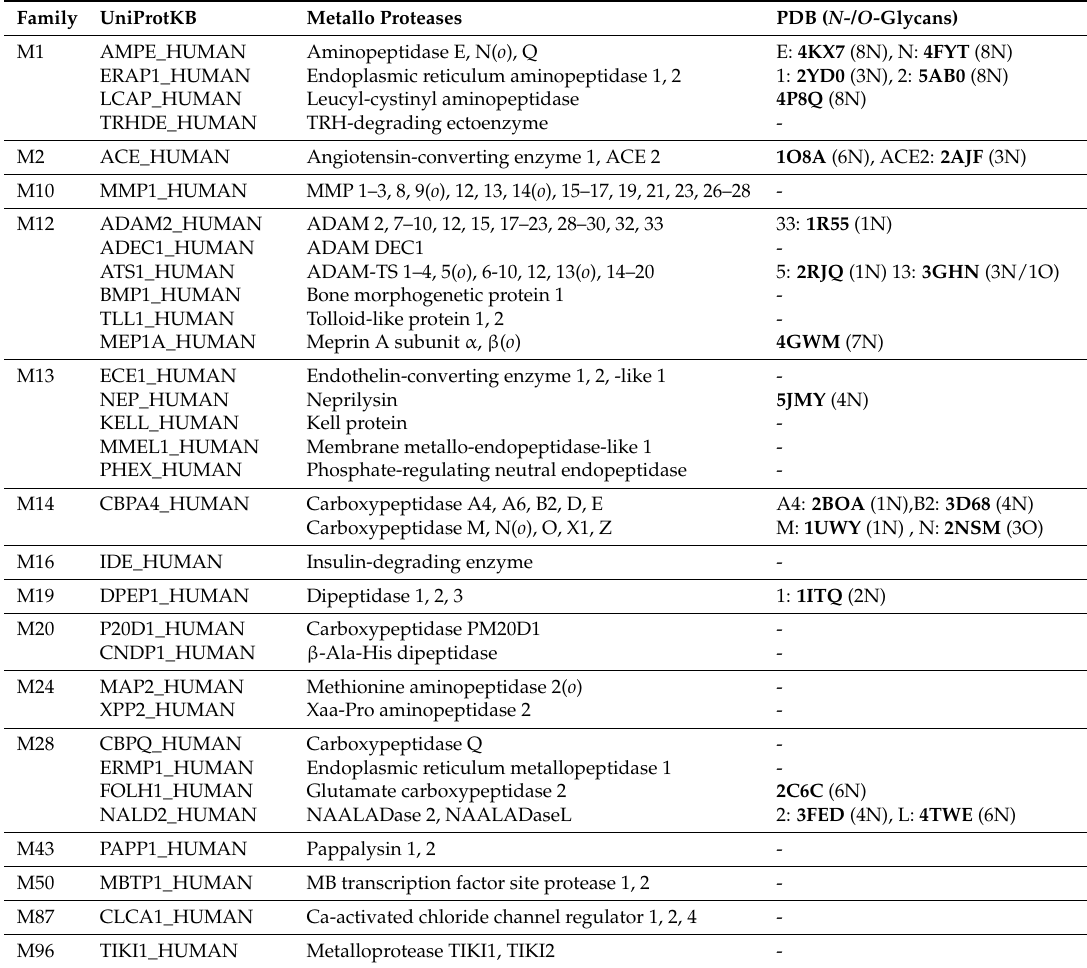
Table 2. Human metalloproteases with glycosylation sites ( o : O -glycans) according to UniProtKB. MEROPS families are M1, M2, M10, M12, M13, M43 (clan MA), M14 (MC), M16 (ME), M19 (MJ), M20, M28 (MH), M24 (MG) and M50 (MM). M87 and M96 have not been assigned to a clan. UniProtKB